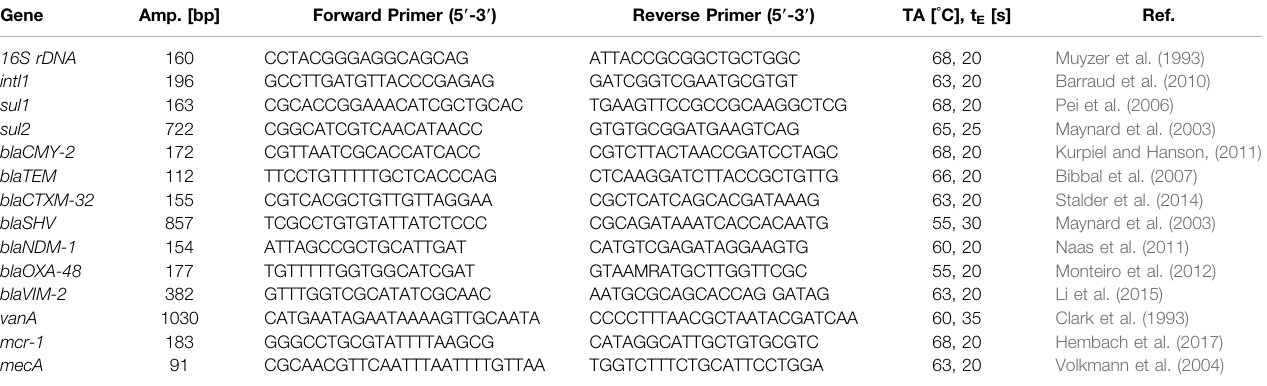
TABLE 1 | Primers and qPCR conditions of the genes studied (TA, Annealing Temperature; tE, Elongation